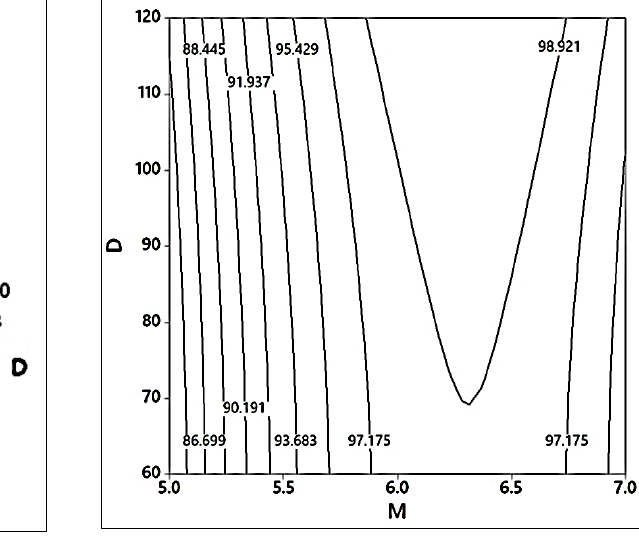
Figure 15. Interaction effect of the reaction temperature (T) and methanol to oil molar ratio (M) on the FAME yield (Y) of the transesterification process. ( a ) A 3D response surface plot of Y (%) vs. T (°C) and M (M). ( b ) A 2D contour plot between T (°C) and M (M).